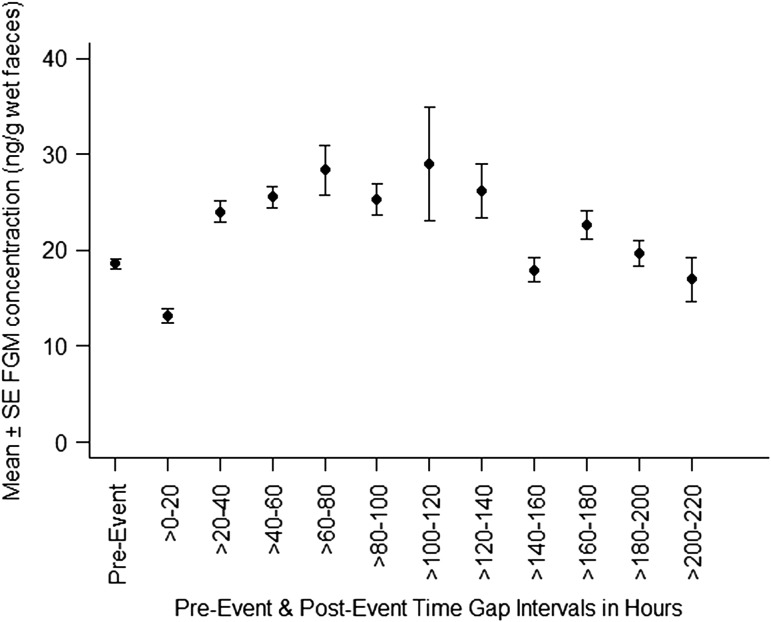
Mean (±SEM) of faecal glucocorticoid metabolite (FGM) concentration (removal of the two highest values above 150 ng/g wet faeces to adjust scale) of pre-event samples and post-event samples, collected >0–220 h after inter-unit interactions.